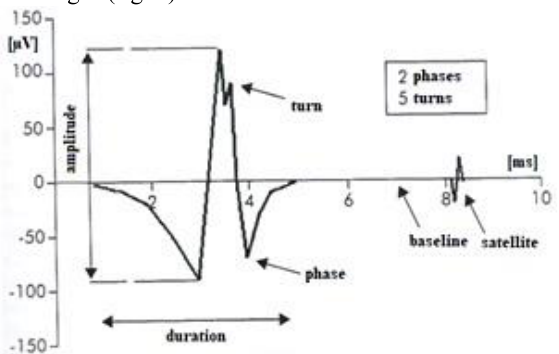
Fig. 2. Parameters measured during the EMG test